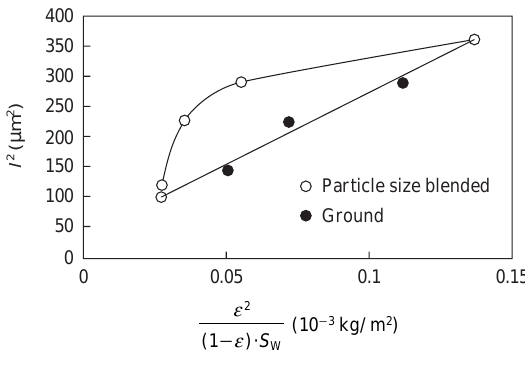
Penetration length as a function of e 2 /{(1 (cid:2) e )· S W }, that is parameter specific surface area and porosity followed by Kozeny-Carman Eq.